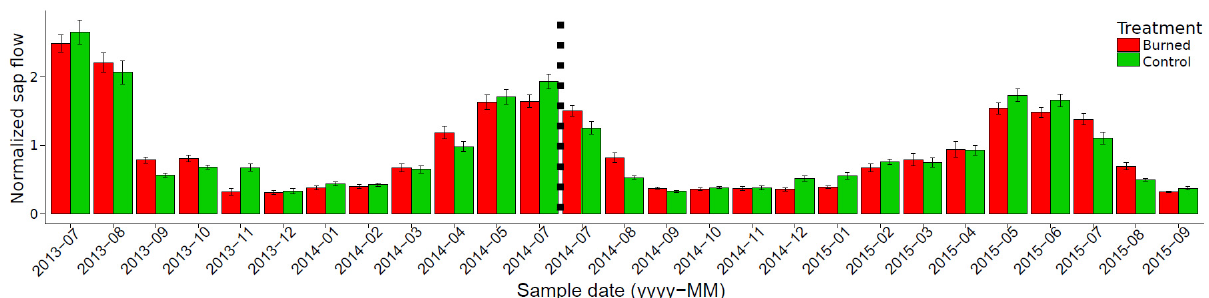
Figure 5. Variations in sap flow from control and burned trees (dm 3 dm –2 h –1 ) between 4 June 2014 and 25 June 2014. The curves represent the average value for all trees in each treatment. The dashed vertical line represents the date of the prescribed burning.